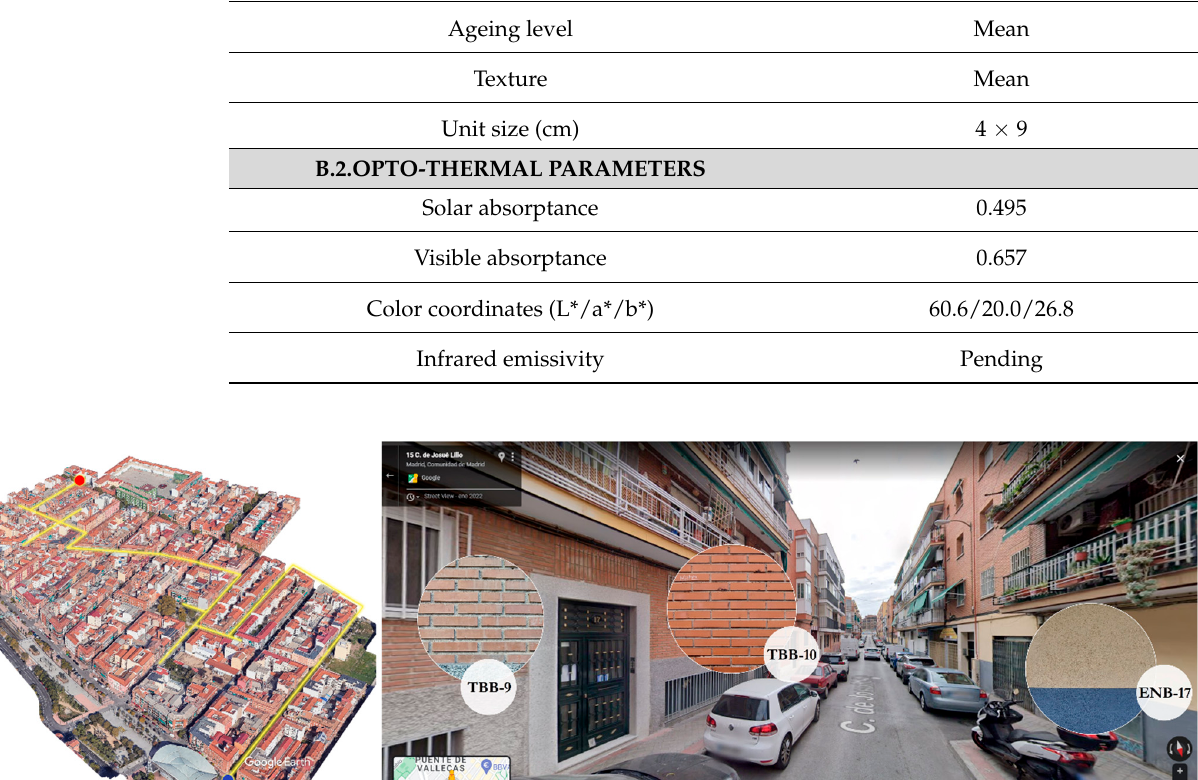
Table 1. Representative information sheet obtained from the experimental campaigns. Neighborhood